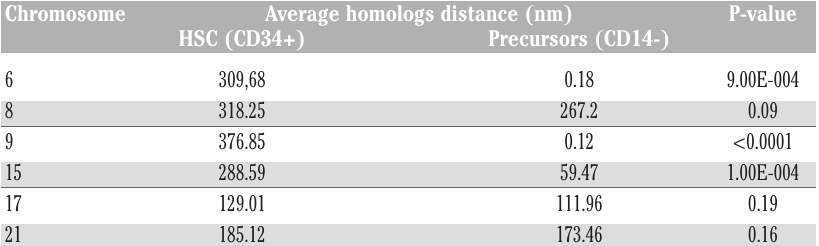
Table 3. Normalized average distance values between the homologs pair in each cell type. P-values are calculated with a Mann-Whitney rank sum test (U-Test). The number of analyzed nuclei per chromosome per cell type was 30.